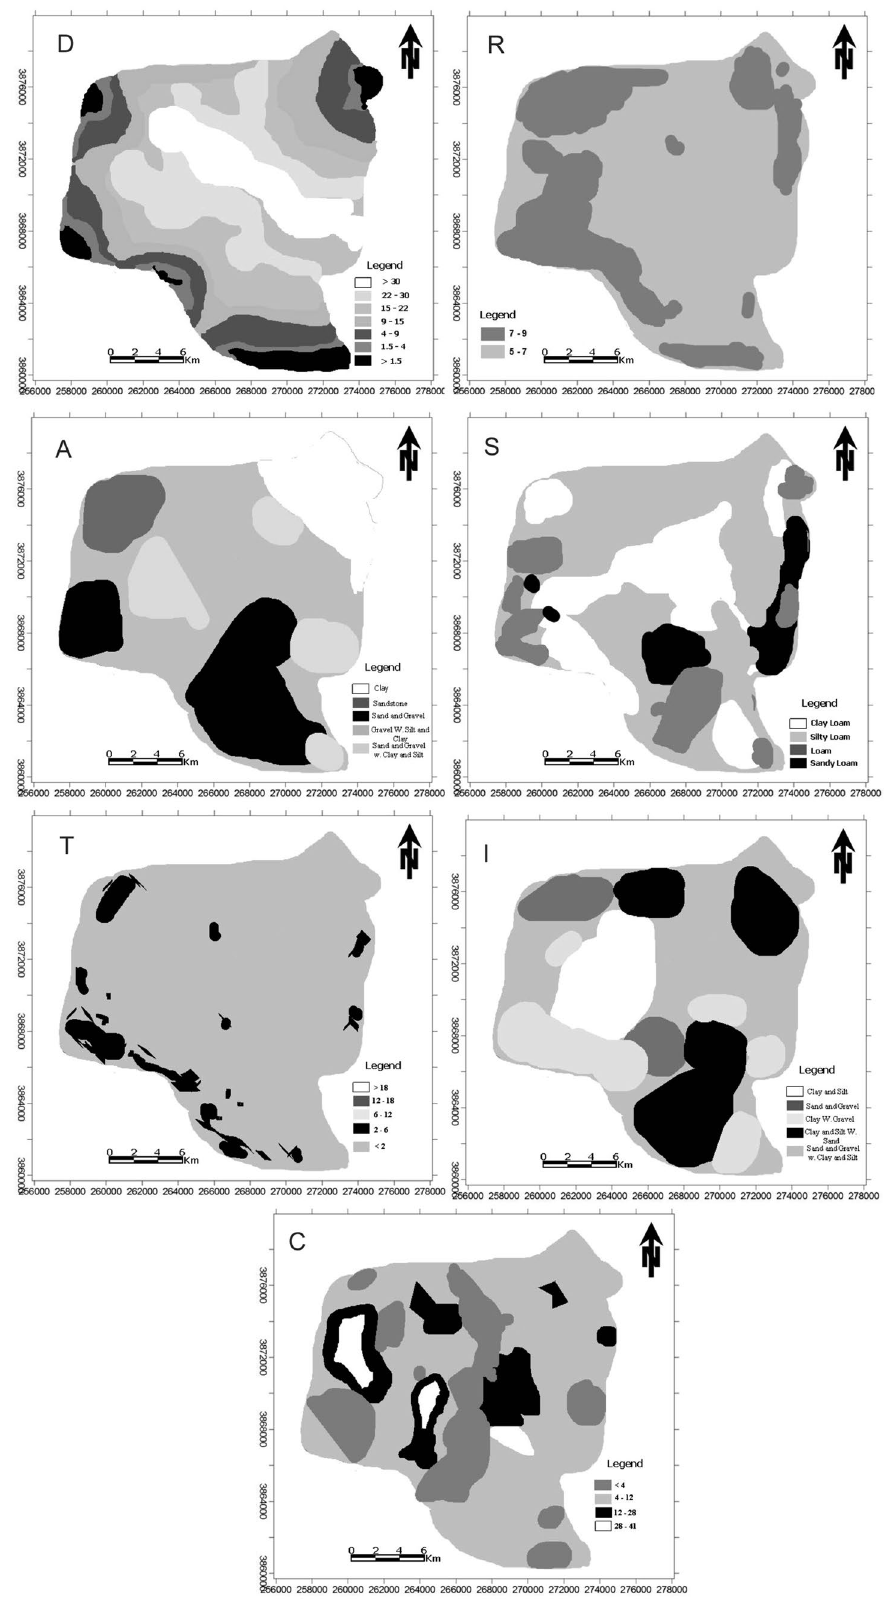
Fig. 3 Mapping of DRASTIC model